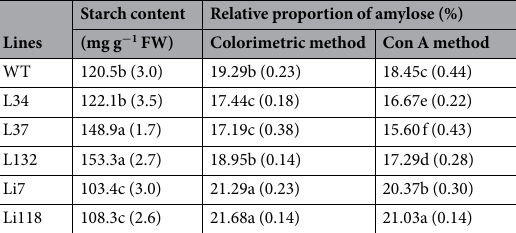
Starch content Relative proportion of amylose (%) Lines (mg g − 1 FW)